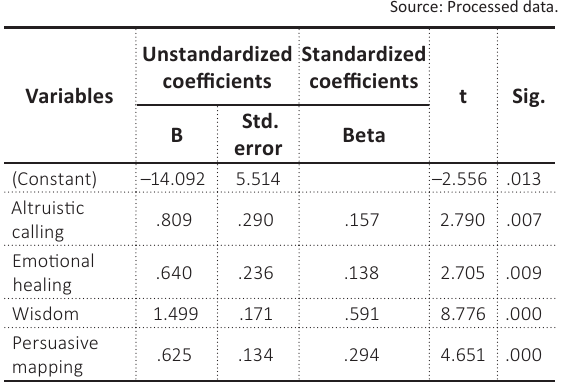
Table 7. Statistics related to retained independent variables in the regression model